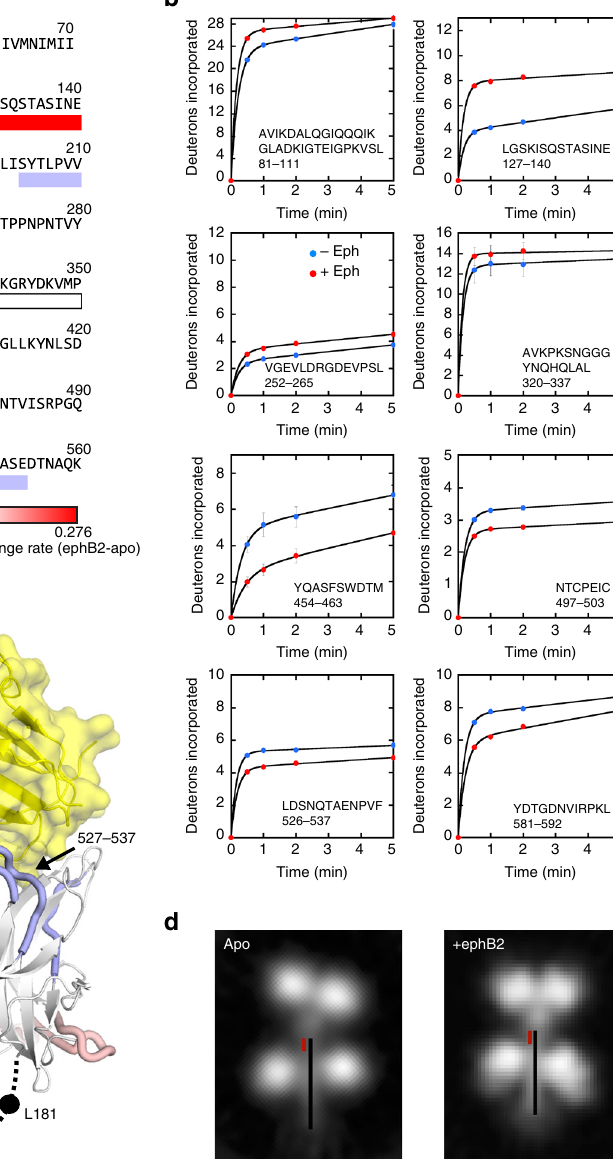
Fig. 5 Hydrogen-deuterium exchange mass spectrometry of the NiV G ectodomain in the presence and absence of monomeric ephrinB2. a Relative fractional exchange rates of NiV G residues. Residue ranges were de fi ned by the heatmap generated with DynamX. b Hydrogen-deuterium exchange rates for selected NiV G peptides from apo- and ephrinB2-167-bound NiV G. Mean and s.d. values for deuterium uptake are shown for each time point, n = 3. c Relative fractional exchange rates of key NiV G regions mapped onto the crystal structure of the NiV G globular domain bound to monomeric ephrinB2. Residue ranges were de fi ned as in a . d Estimated location of the predicted α -helical stalk region of NiV G ( black line ) superposed on a representative 2D class average of NiV G obtained by electron microscopy. The estimated location of peptide 127 – 140, which undergoes the greatest increase in exchange upon ephrinB2-167 binding is shown with a red line HDX-MS of apo- and ephrinB2-167-bound NiV G . To further The peptide exchange data reveal a wide variety of exchange test the possibility that monomeric ephrin binding induces differences in both the head and stalk domains due to monomeric changes in NiV G and to gain insight into speci fi c regions of G ephrinB2 binding. Some peptides are unaffected by the presence that undergo changes upon ephrinB2 binding, we conducted of receptor (white). Other peptides show reduced exchange when HDX-MS experiments in the presence and absence of ephrinB2- receptor is bound (blue), indicating potential stabilization of the 167. The shorter ephrinB2 construct was used to minimize G structure, while other peptides show signi fi cant increased potential peptide overlaps with G. The H/D exchange differences exchange in the presence of receptor (red). Strikingly, the between ephrinB2-bound and unbound G in peptide regions predicted alpha-helical region of the stalk contains two peptides throughout G are shown in a composite heat map of peptide that de fi ne one of the predominant regions with increased H/D exchange rates in Fig. 5a. Time-dependent data on individual exchange (Fig. 5a). These peptides span residues 81 – 111 and peptides showing notable differences in exchange rate are shown 127 – 140. These residues are not involved in ephrinB2 binding, in Fig. 5b. indicating that receptor binding induces an allosteric change in NATURE COMMUNICATIONS | 8: